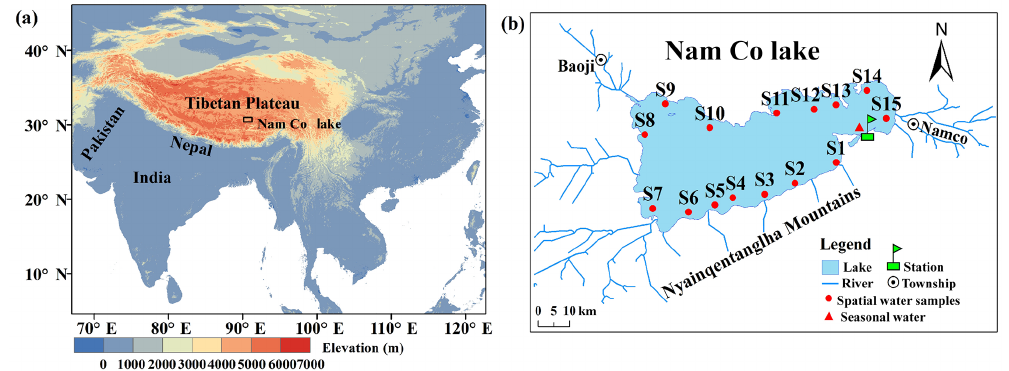
Figure 1. Location of Nam Co lake on the Tibetan Plateau (a) and the sampling sites for air and lake water (b) . The station is the Nam Co Monitoring and Research Station, and it is also the air-sampling site; S01 to S15 represent the 15 sampling sites of surface water around the lake; the red triangle represents the sampling site of seasonal water from May to